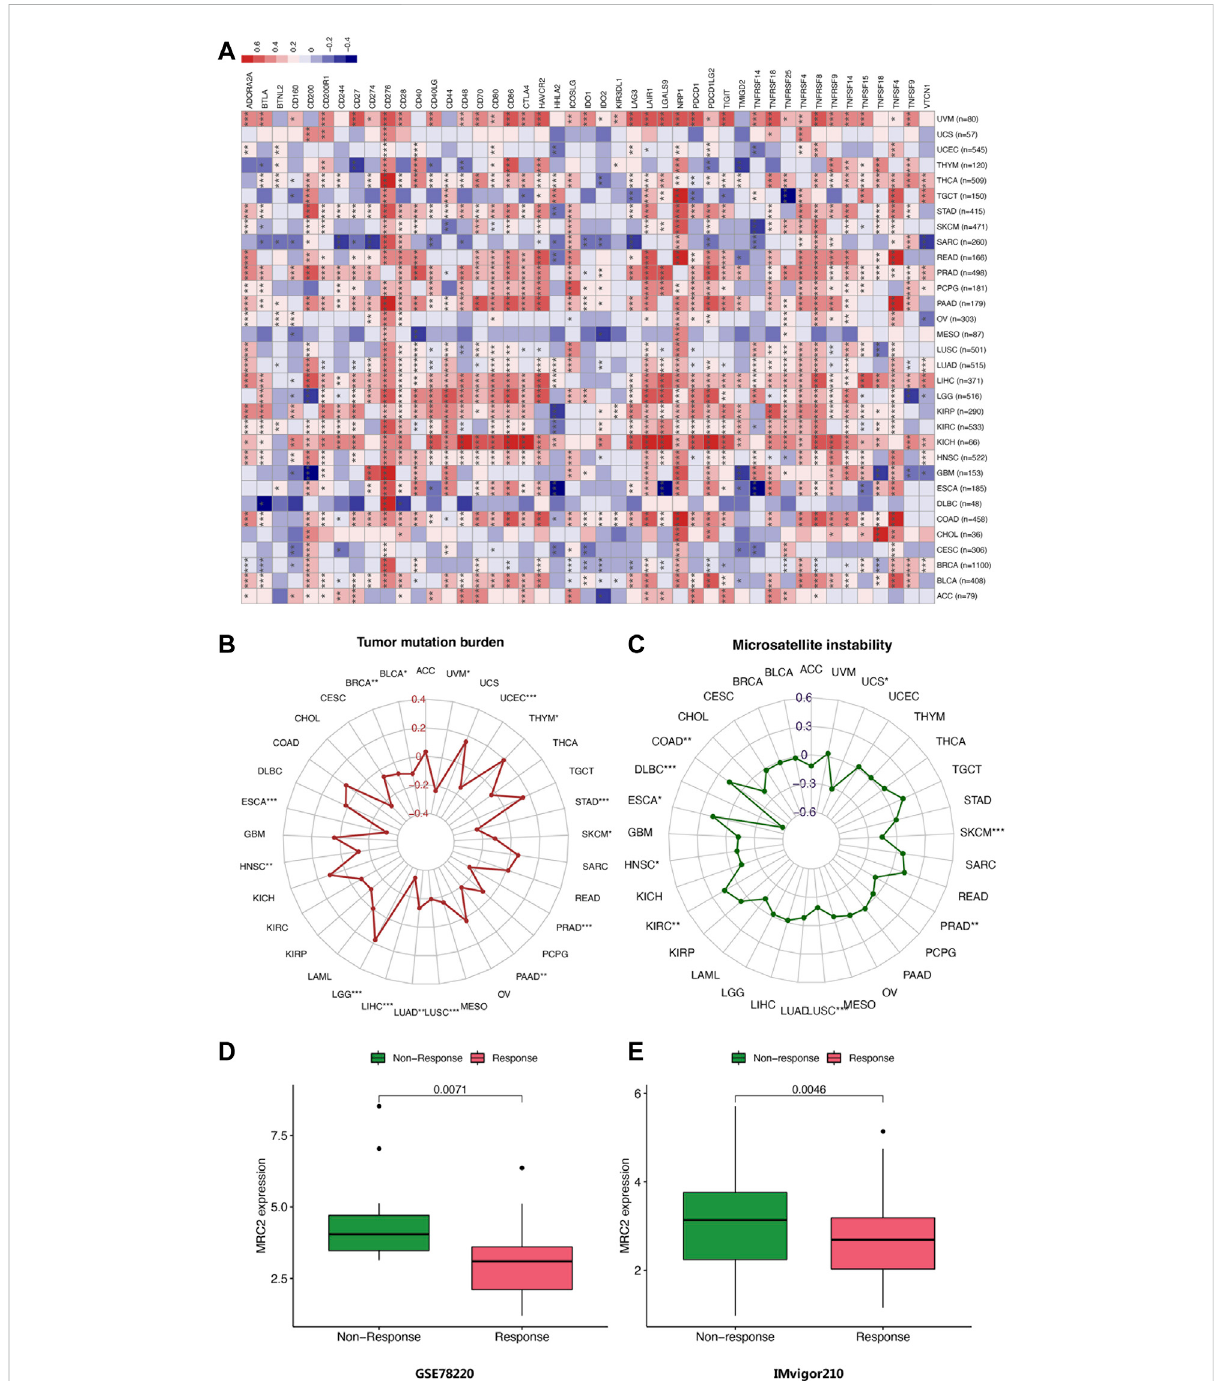
FIGURE 5 (A) Correlation of MRC2 expression with expression of immune checkpoint genes calculated by TIMER. Red indicates positive correlation, whereas blue indicates negative correlation. “ * ” indicates p < 0.05, “ ** ” indicates p < 0.01 and “ *** ” indicates p < 0.001. (B) Correlations between MRC2 expression and TMB. (B,C) Correlation between MRC2 and MSI. (D – E) Correlations between MRC2 and immunotherapeutic response in immunotherapeutic